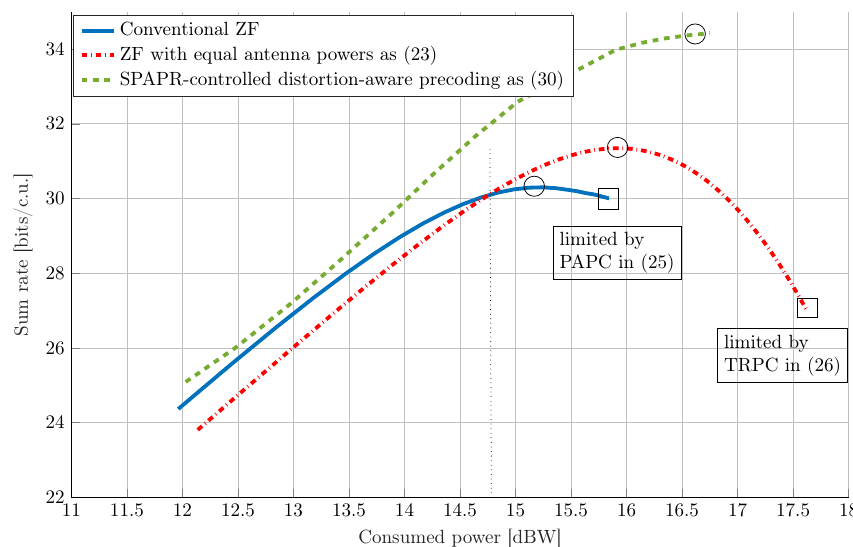
Figure 4. Energy efficiency comparison between P SPDA , P EAP , and conventional ZF precoding averaged over the realizations of the geometric channel (4) for a setup with B = 32 antennas and U = 4 UEs. The maximum output power at each PA is ρ ( b ) max = 30dBm, and the maximum power efficiency is η ( b ) max = 0.55 for b = 1, . . . , B . The nonlinearity characteristics of the PAs are as in (2) with = 1 and β ( b ) = − 0.0426 − 0.0191 j for b = 1, . . . , B . K = 1, β ( b ) 3 1 Table 1. Resulting average received useful signal and nonlinear distortion power for conventional ZF and ZF with EAP for a total consumed power equal to ρ ( tot ) cons = 15.25dBW. Avg. Rx. Useful Sig.